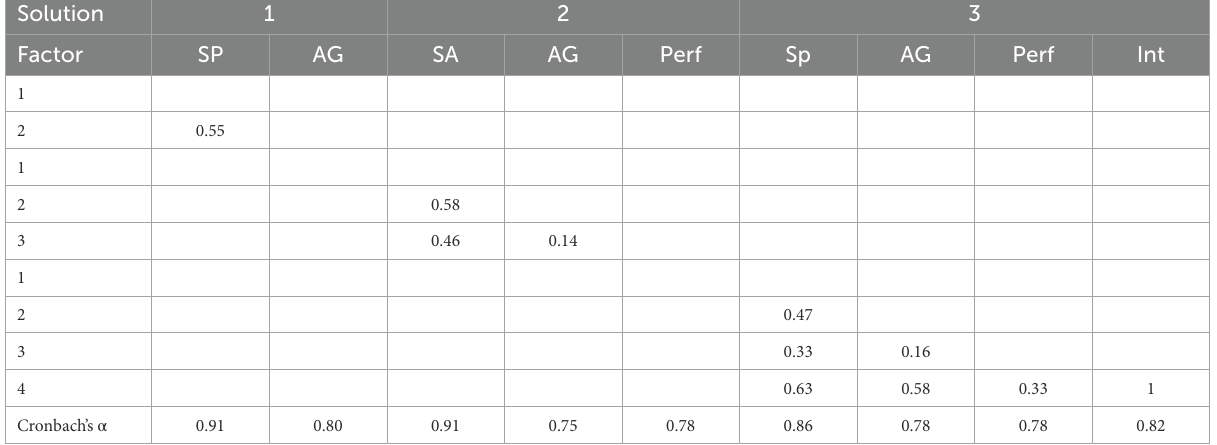
TABLE 5 Correlations between factors for each solution and Cronbach’s alphas for each extracted